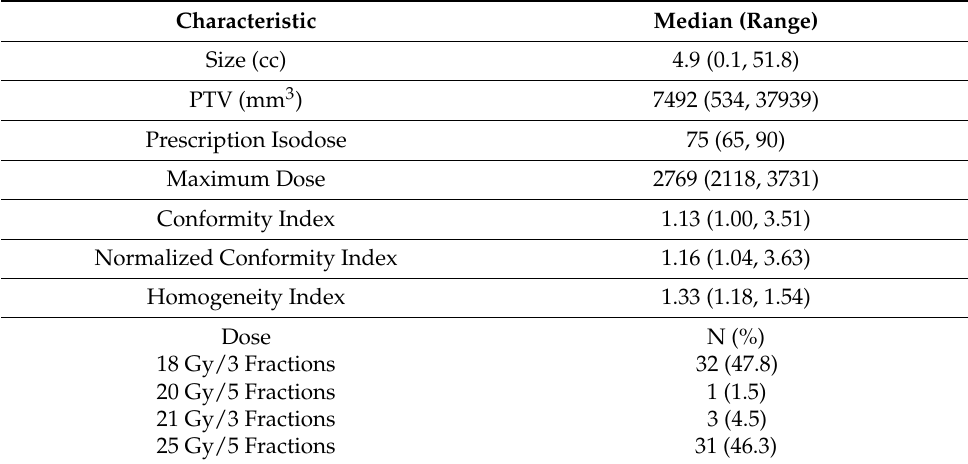
Table 2. Treatment